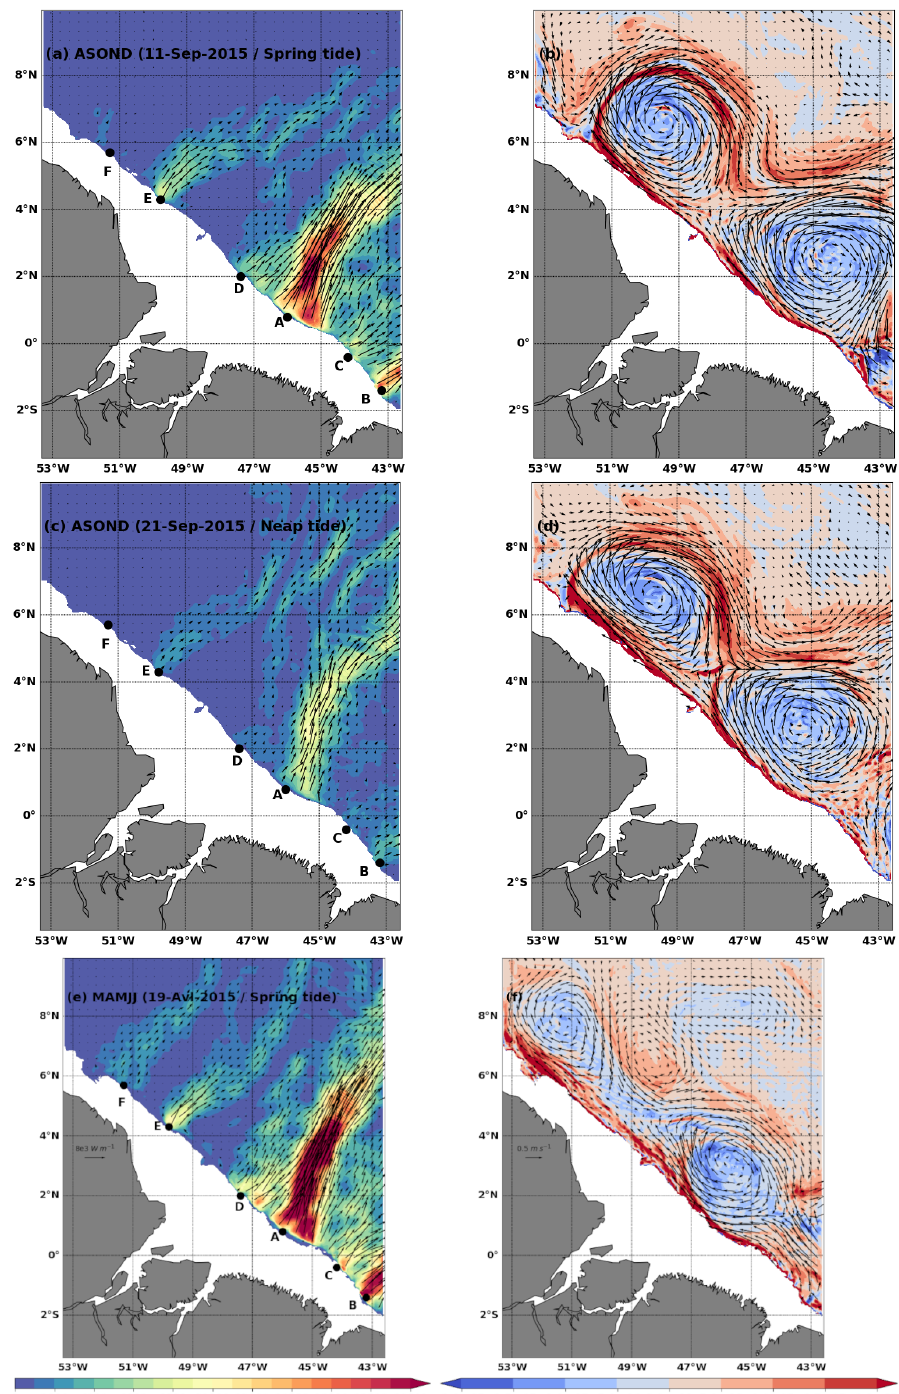
Figure 9. Examples of 25h mean snapshots of depth-integrated baroclinic flux (colours and arrows, left, units: Wm − 1 ), relative vorticity along the 1025kgm − 3 isopycnal (colour, right, units: s − 1 ), and horizontal velocity along the 1025kgm − 3 isopycnal (arrows, right, units: m − 1 ) on (a, b) 11 September 2015 spring tide during ASOND, (c, d) 21 September 2015 neap tide during ASOND, and (e, f) 19 April 2015 spring tide during MAMJJ. Bathymetry less than 100m is